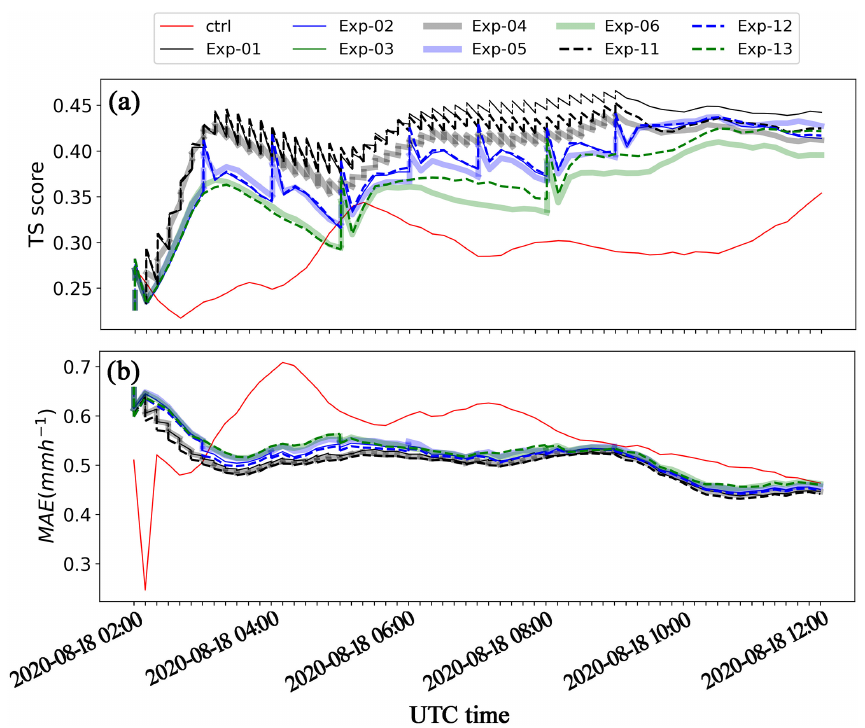
Figure 16. Time evolution of (a) the TS score and (b) MAE of the ensemble mean of the first-guess forecast for rain